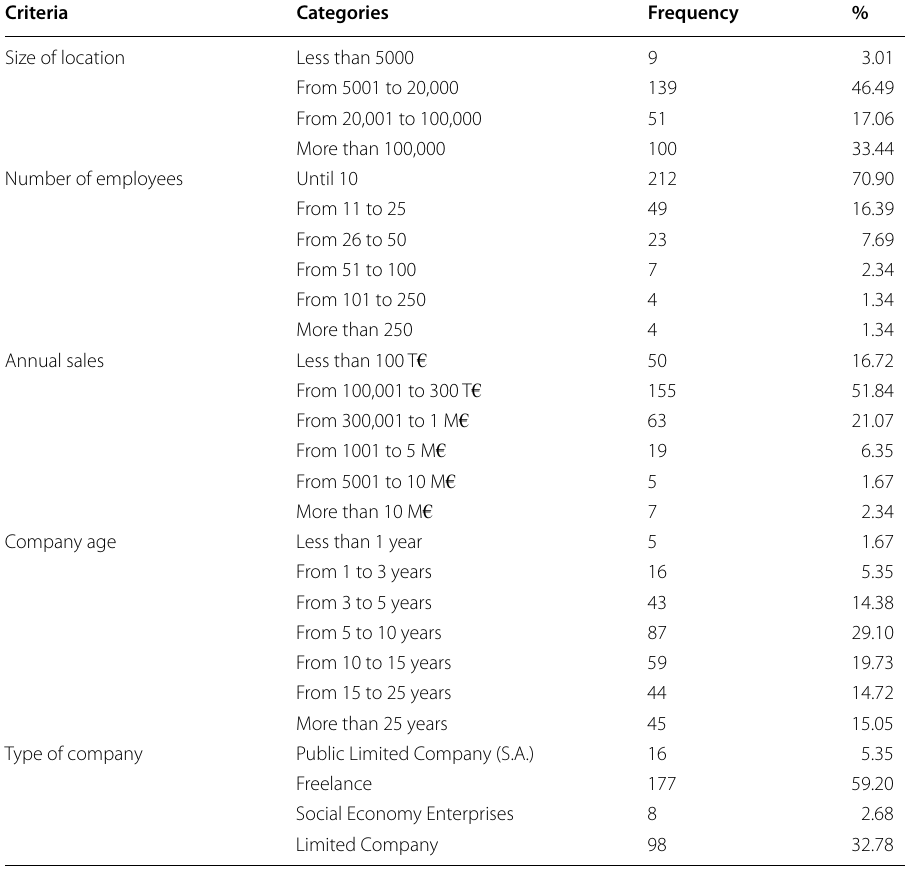
300) per different criteria =